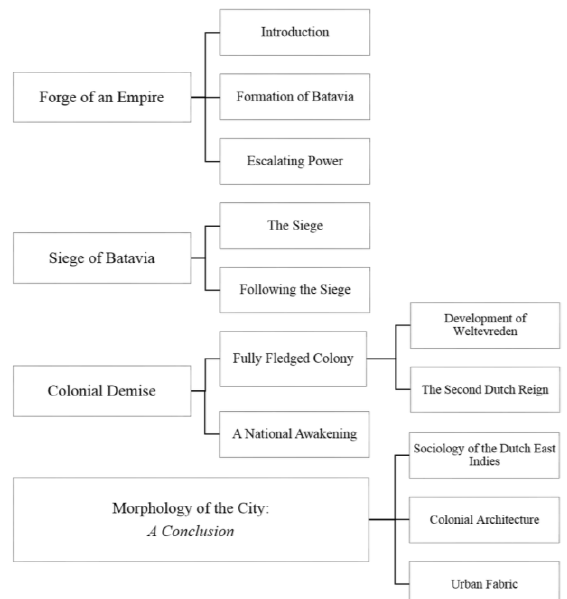
Figure 1. Structure of the Study (Developed by Author).